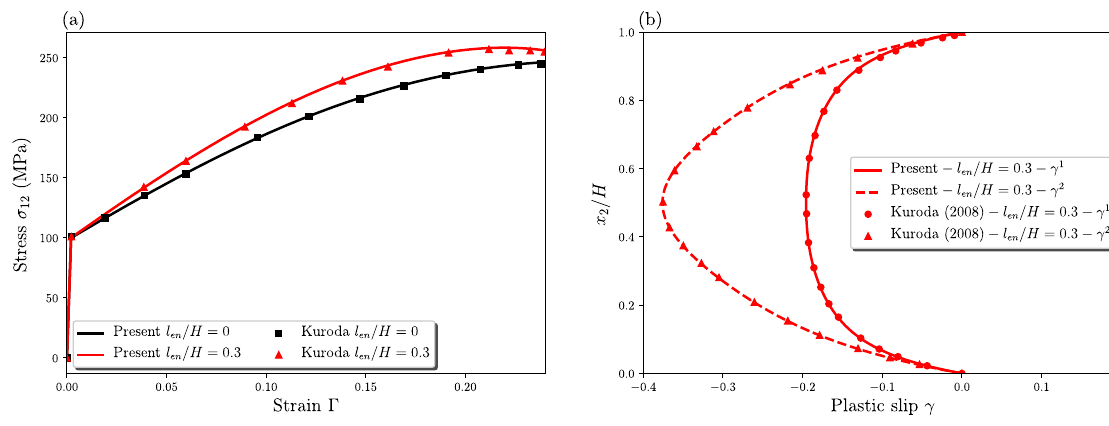
Figure 4. Large shear loading results in terms of the ( a ) stress–strain curves and ( b ) distributions of the total plastic variables γ α along the x 2 direction: comparison between the present model and the model of [49] for different values of l en / H